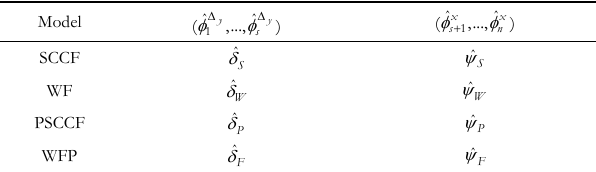
Estimators of the common features vectors and RRR coefficients